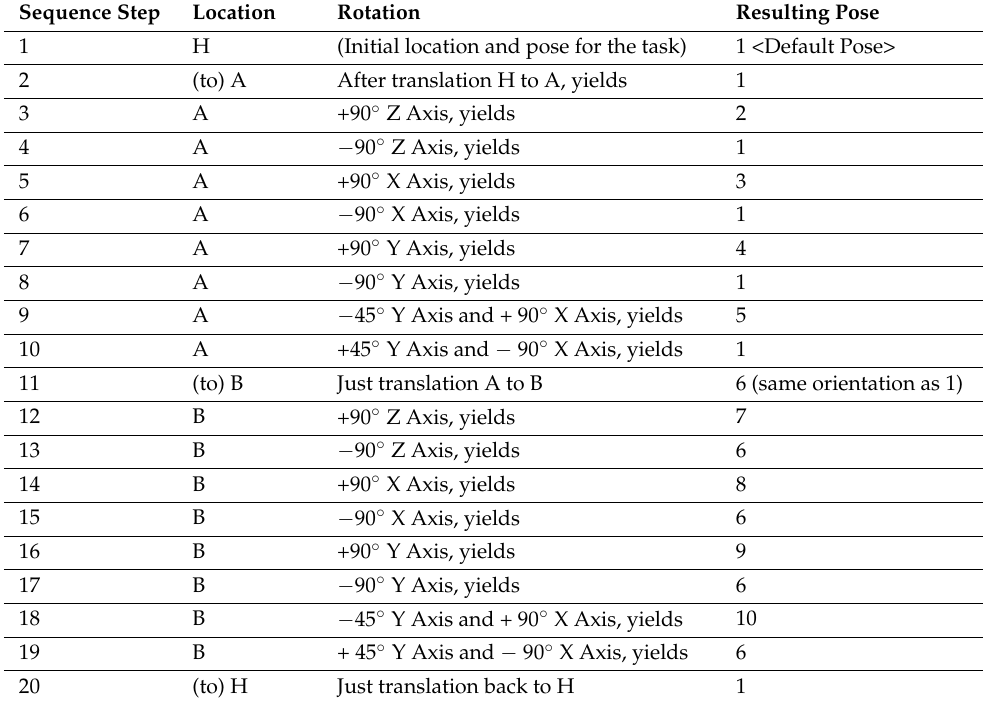
Table 3. Sequence of steps in each recording